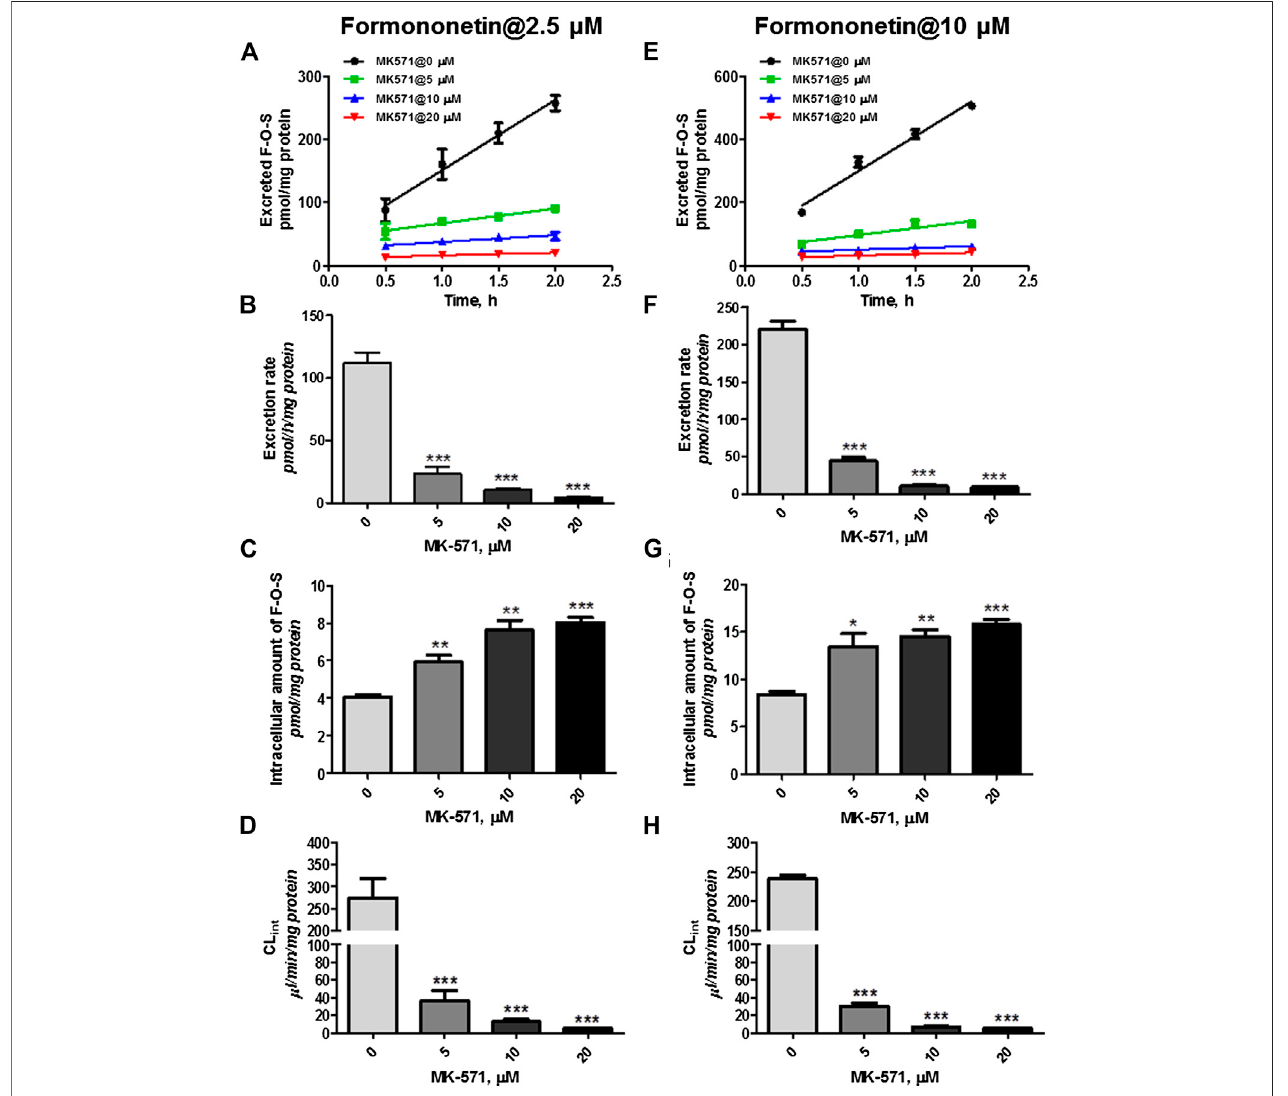
FIGURE 8 | Effects of MK-571 (5 – 20 μ M) on formononetin (2.5 and 10 μ M) disposition in HEK-SULT1A3 cells. Effects of MK-571 on the excretion pro fi le (A) , intracellular amounts (B), and ef fl ux clearances (C) of formononetin sulfate at a low loading concentration of formononetin (2.5 μ M). Effects of MK-571 on the excretion pro fi le (D) ,intracellularamounts (E), andef fl uxclearances (F) offormononetinsulfateatahighloadingconcentrationofformononetin(10 μ M).* p < 0.05,** p < 0.01,*** p < 0.001 compared with control. Each data point was shown as mean ± SD (n (cid:1) 3).